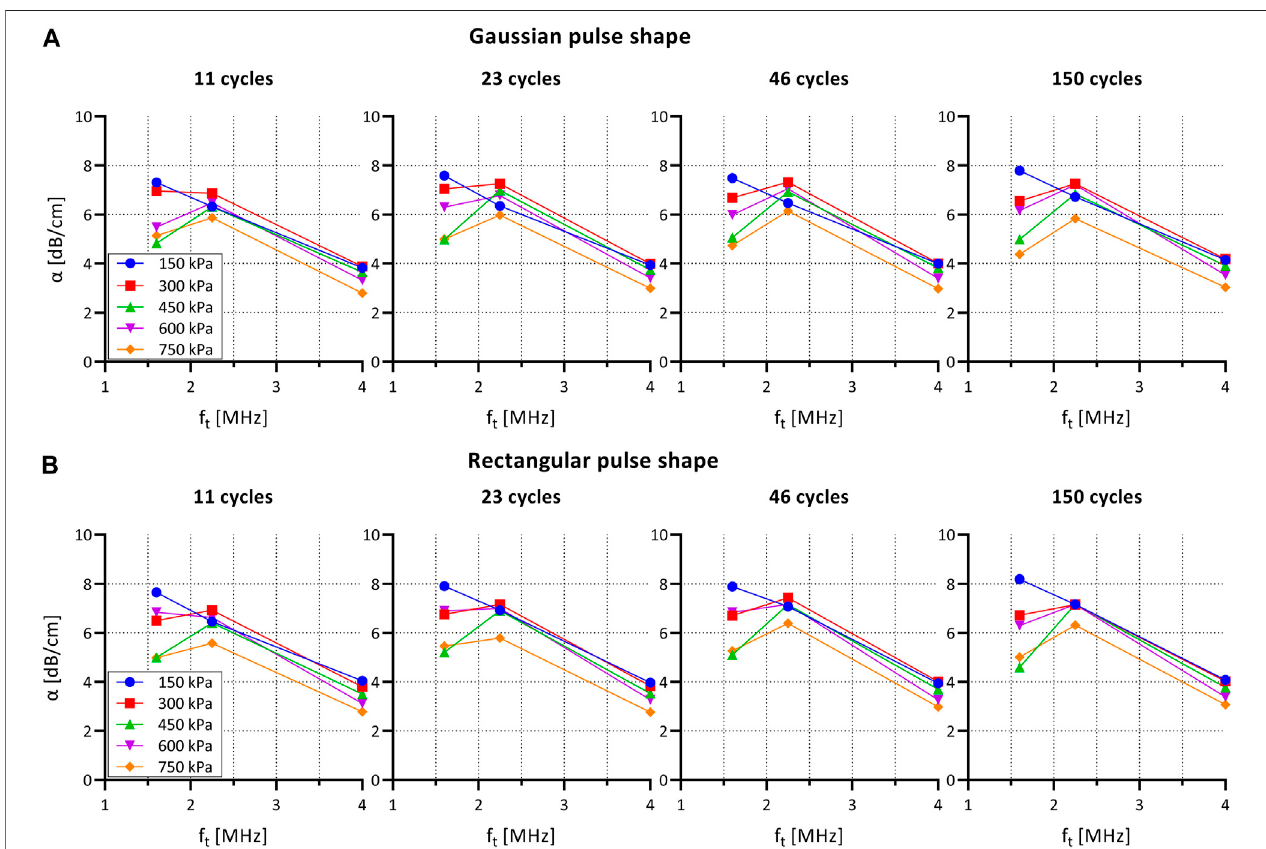
FIGURE 3 | Attenuation coef fi cient α for SonoVue for different pulse shapes and lengths as a function of acoustic pressure and frequency. (A) Gaussian pulse envelop (as used in PW Doppler mode on clinical US system). (B) Rectangular pulse envelop (as used in single-element set-up). α : attenuation coef fi cient; f t : transmit